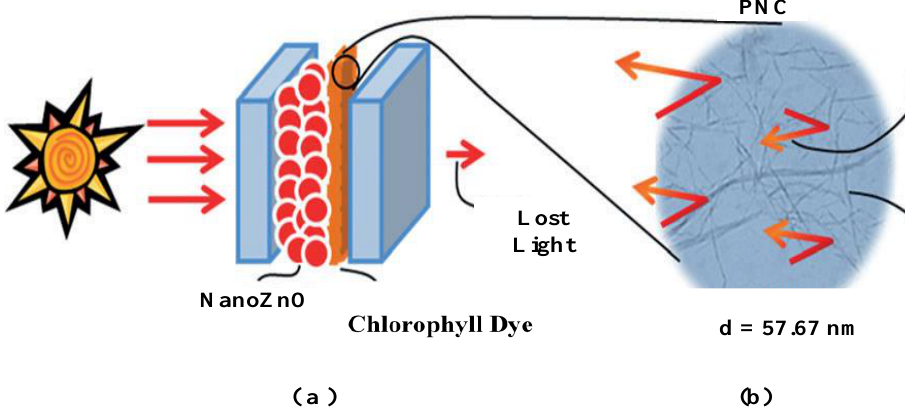
Figure 3. ( a ) Schematic diagram of the proposed dye-sensitised solar cell. ( b ) Magnified view of the charge-injection process [55].